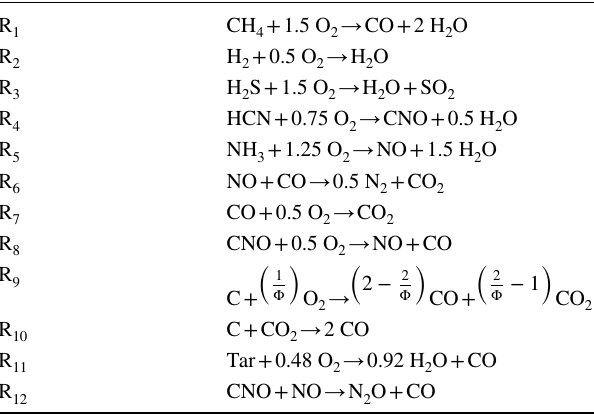
Notes : 𝛷 is a factor of a mechanism governed by particle